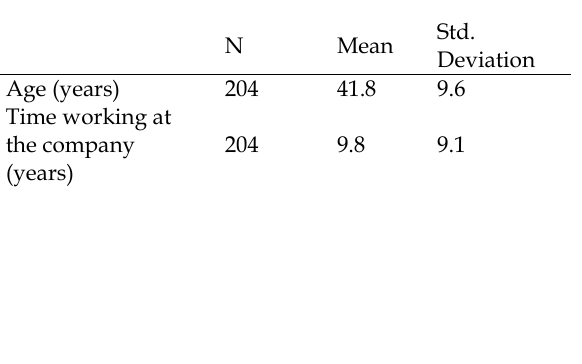
Table 2. Age and time work at the company descriptive